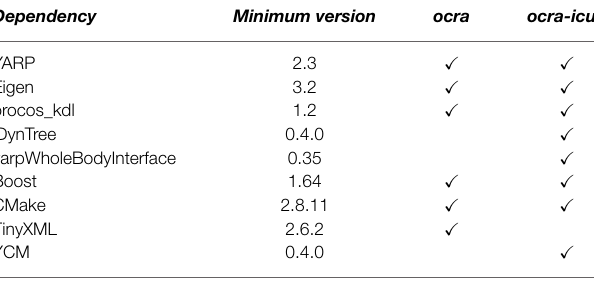
TABLE 1 | Required dependencies table for ocra and